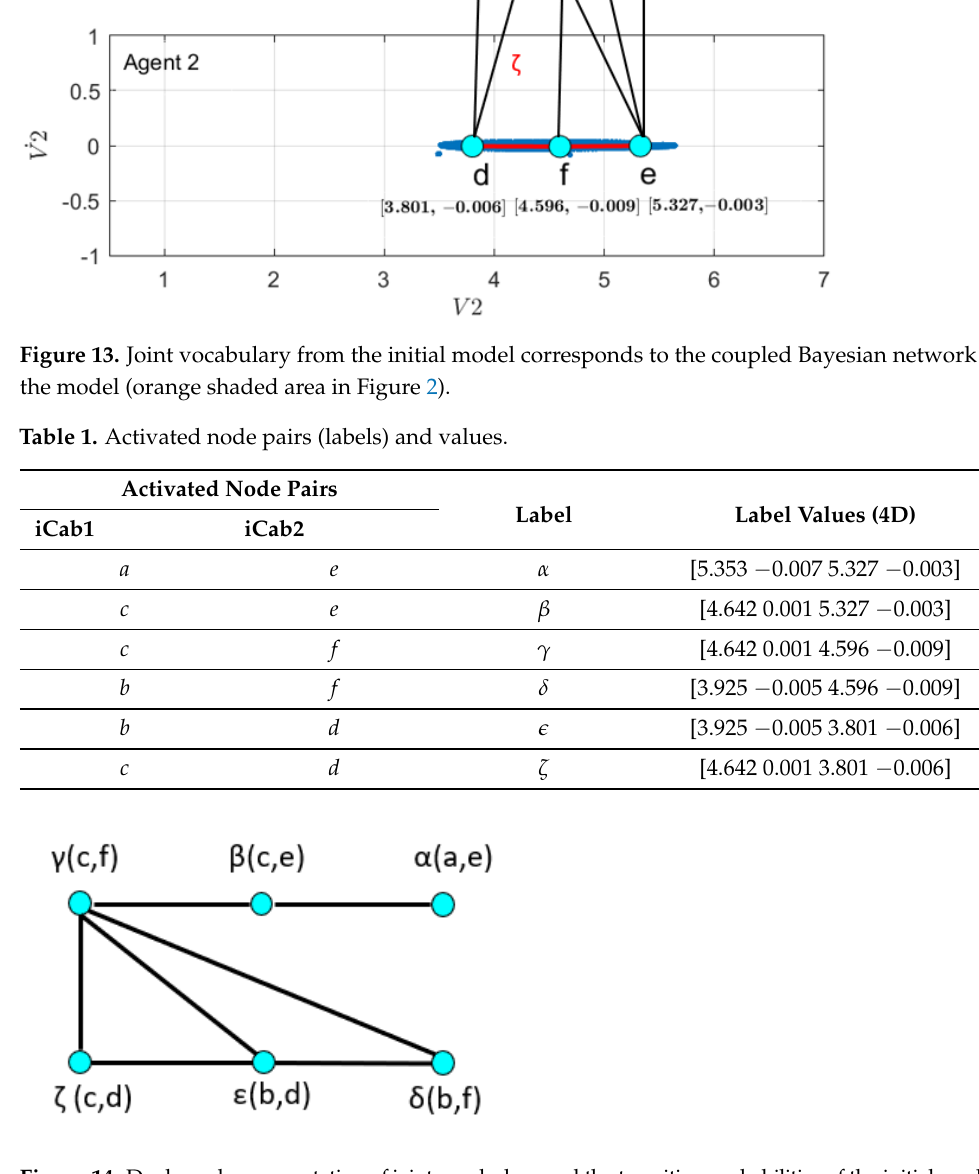
Figure 14. Dual graph representation of joint vocabulary and the transition probabilities of the initial